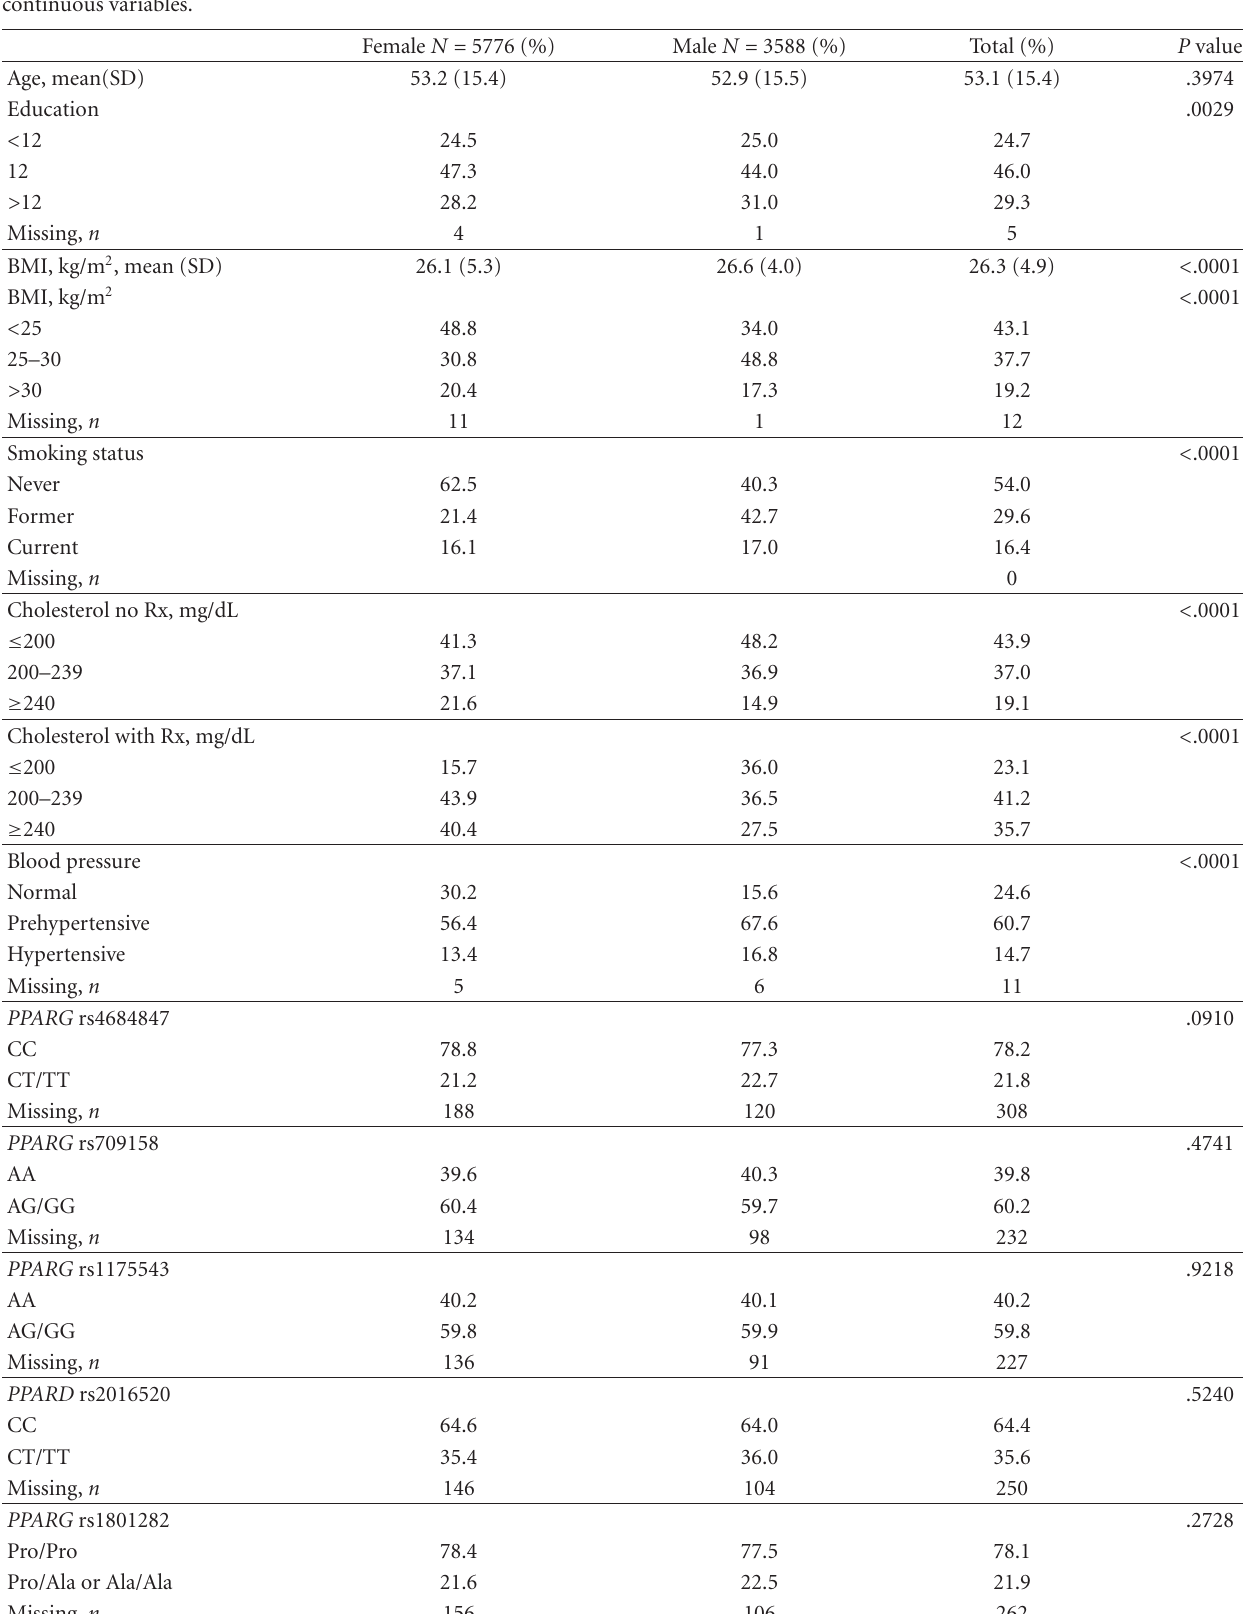
Table 1: Characteristics of study sample by gender, N = 9364, P value derived from χ 2 test for categorical variables, Student’s t-test for continuous